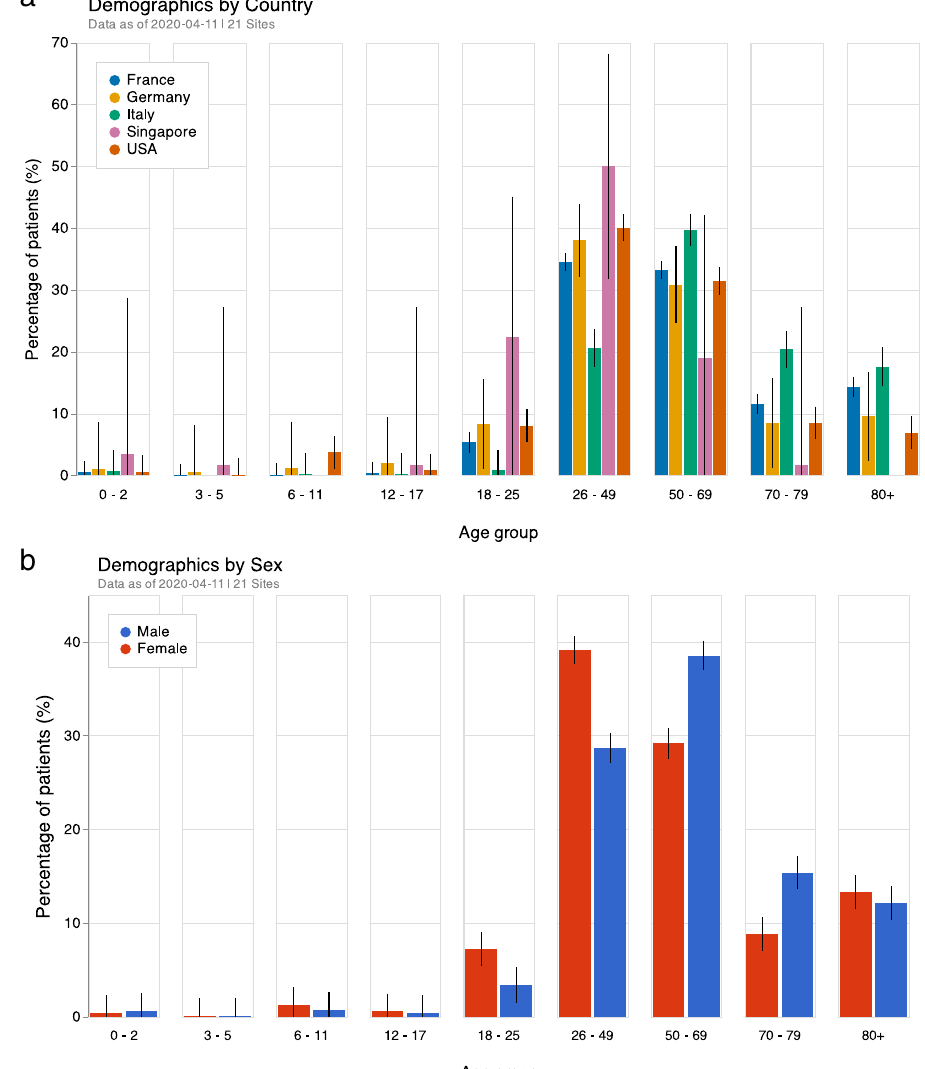
Fig. 1 Percentages of patients along with 95% con fi dence intervals in each a country and b sex age